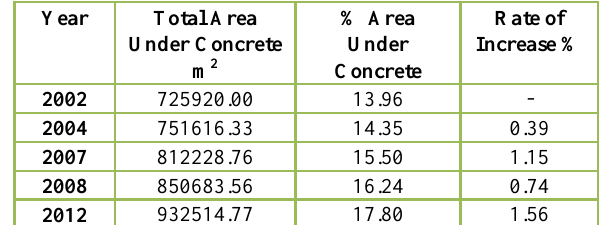
Figure 4. Cumulative Area under concrete for the years 2002, 2004, 2007, 2008, and 2012.